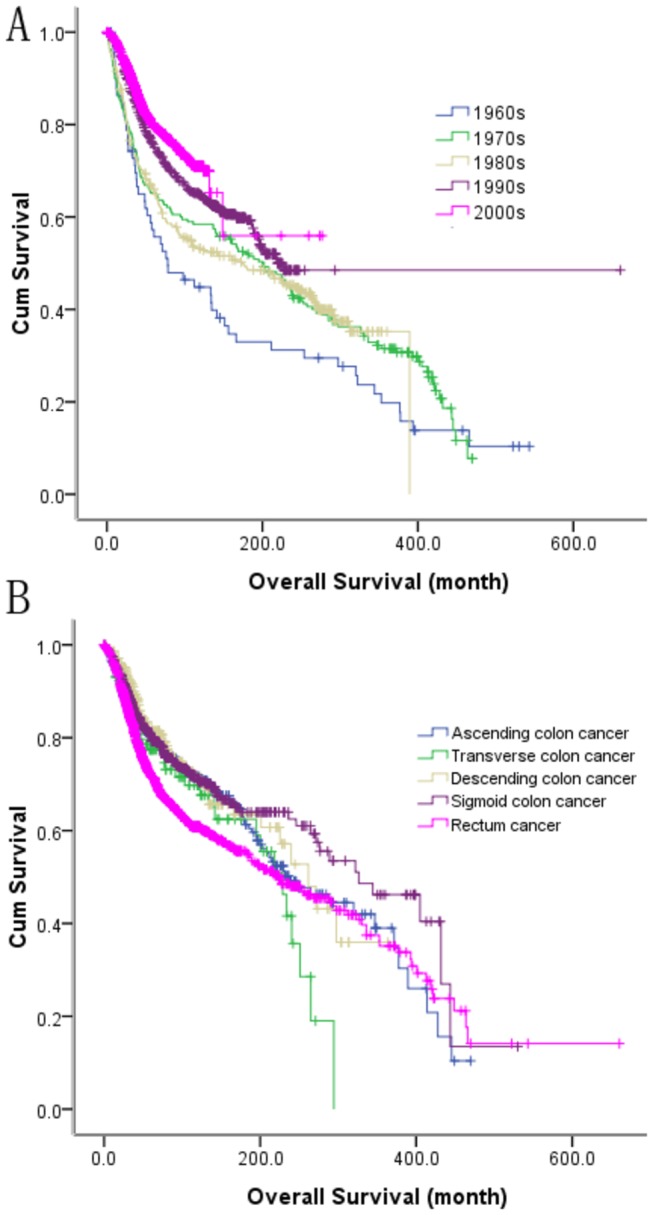
The survival curves for patients in different time durations (A) and with different tumor locations (B).